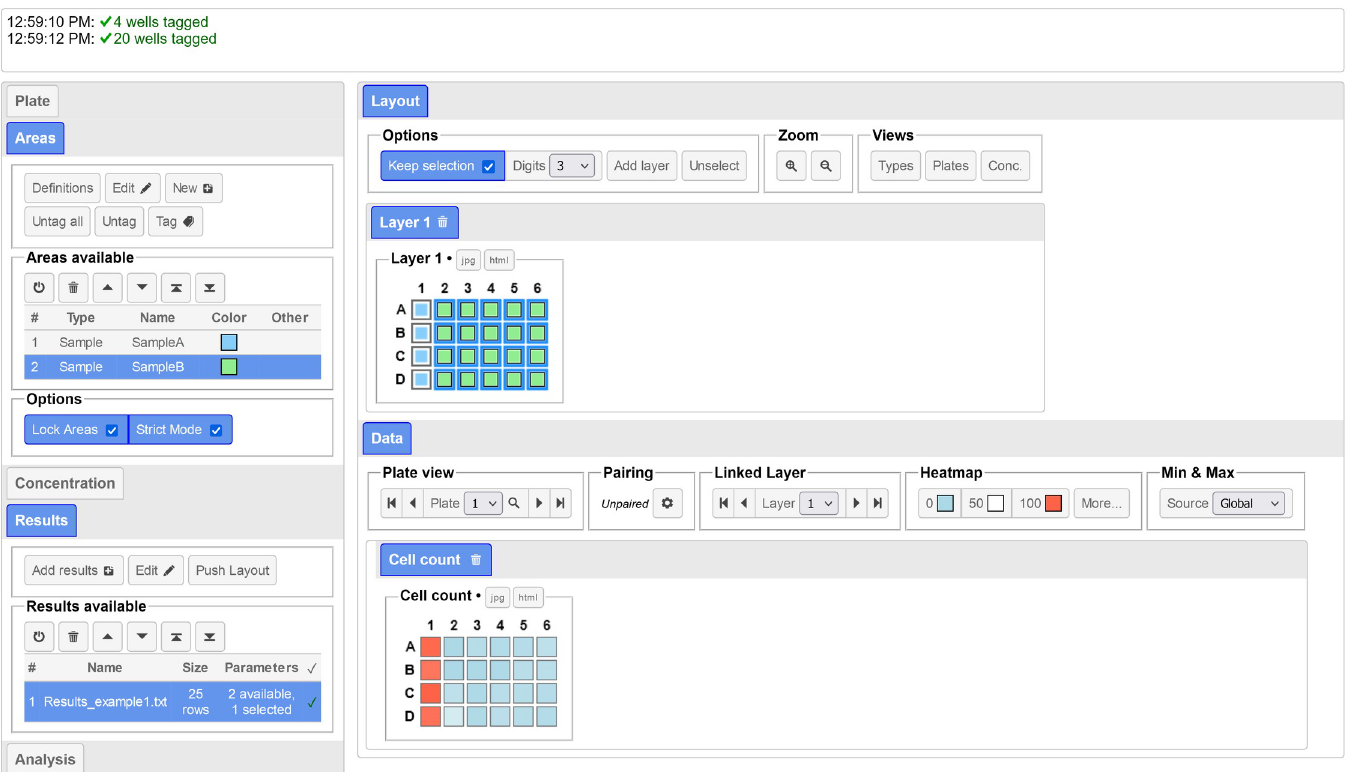
Fig 1. Overview of PlateEditor . Top: console panel, in which feedback messages are displayed. Left: menu panel, includes all the controls and options for management of the layout, creation and tagging of areas, loading of result and definition files, as well as the analysis tools. Right: main section, divided into two panels; the Layout panel on top is used to select wells and tag the Areas. The Data panel at the bottom allows visualization of the data from the selected result files as heatmaps. This figure can be reproduced using the files from the Simple example.